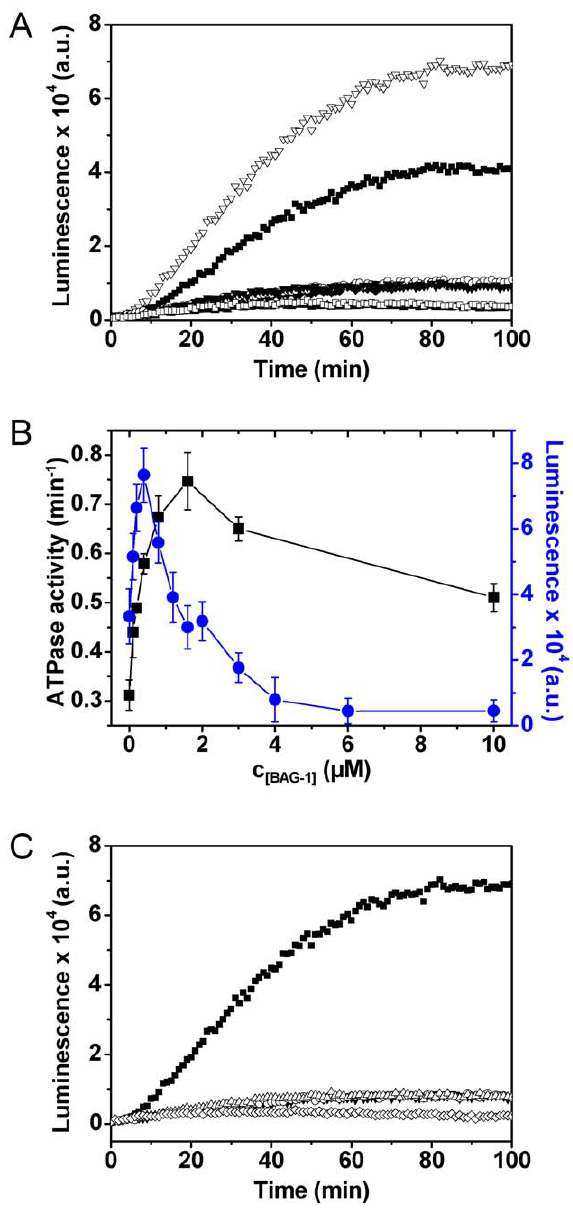
Figure 6. Lid domain truncations reduce the refolding ability of CeHsc70. ( A ) Kinetics of firefly luciferase refolding in the presence of different chaperone combinations: CeHsc70/DNJ-13/BAG-1 ( = ), CeHsc70/DNJ-13 ( & ), CeHsc70/BAG-1 ( ¤ ), CeHsc70 ( # ), BAG-1 ( % ) and DNJ-13 ( . ). Additionally the luminescence of a sample without chaperones and cofactors was analyzed ( m ). Protein concentrations were 3.2 m M CeHsc70, 0.8 m M DNJ-13 and 0.4 m M BAG-1. Luciferase refolding assays were carried out as described in Material and Methods. ( B ) Steady-state ATPase activities (black squares, left ordinate) and luciferase refolding efficiency (blue circles, right ordinate) were determined for 3.2 m M CeHsc70 and 0.8 m M DNJ-13 at different BAG- 1 concentrations under standard conditions. ( C ) The luciferase refolding activity of either CeHsc70 ( & ), CeHsc70- D 545 ( . ), CeHsc70- D 512 ( # ) or CeHsc70- D 384 ( D ) was determined in the presence of DNJ-13 and BAG- 1. Additionally a control without chaperones and cofactors ( e ) was